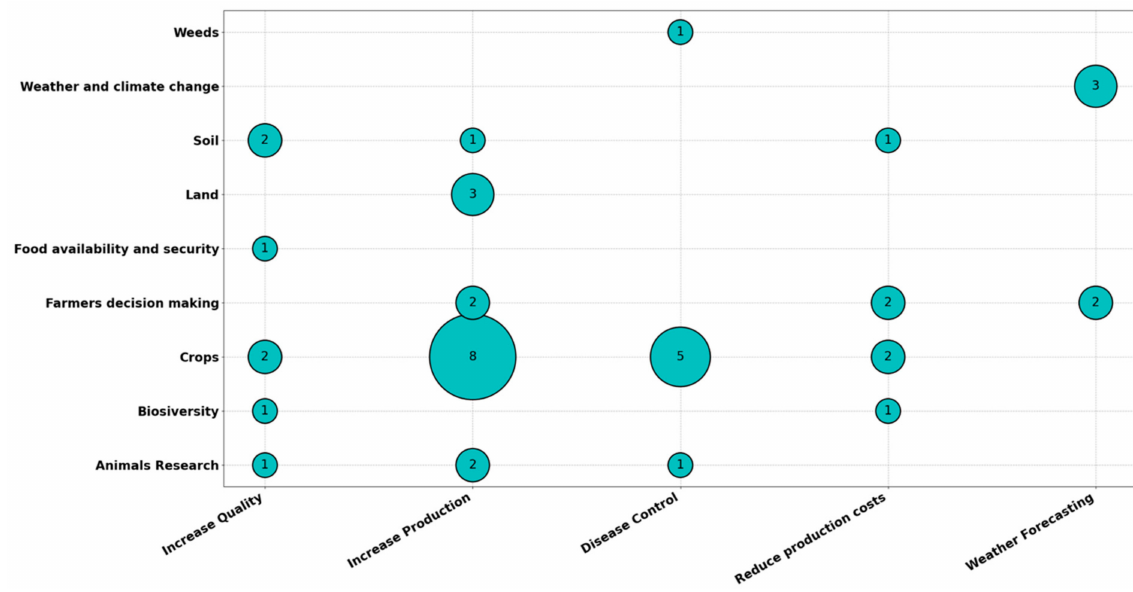
Figure 17. Agriculture types versus the types of problems